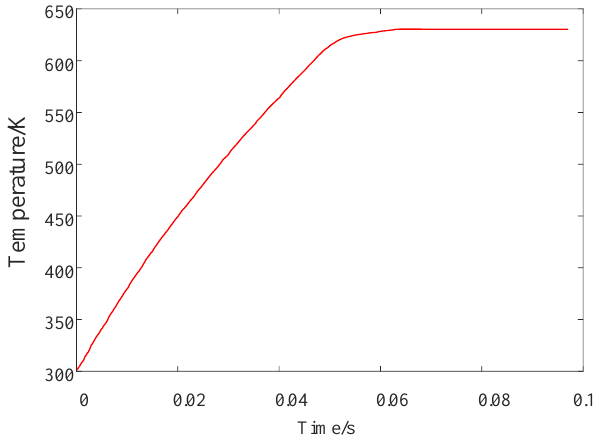
Figure 12. The fluid flow velocity diagram.